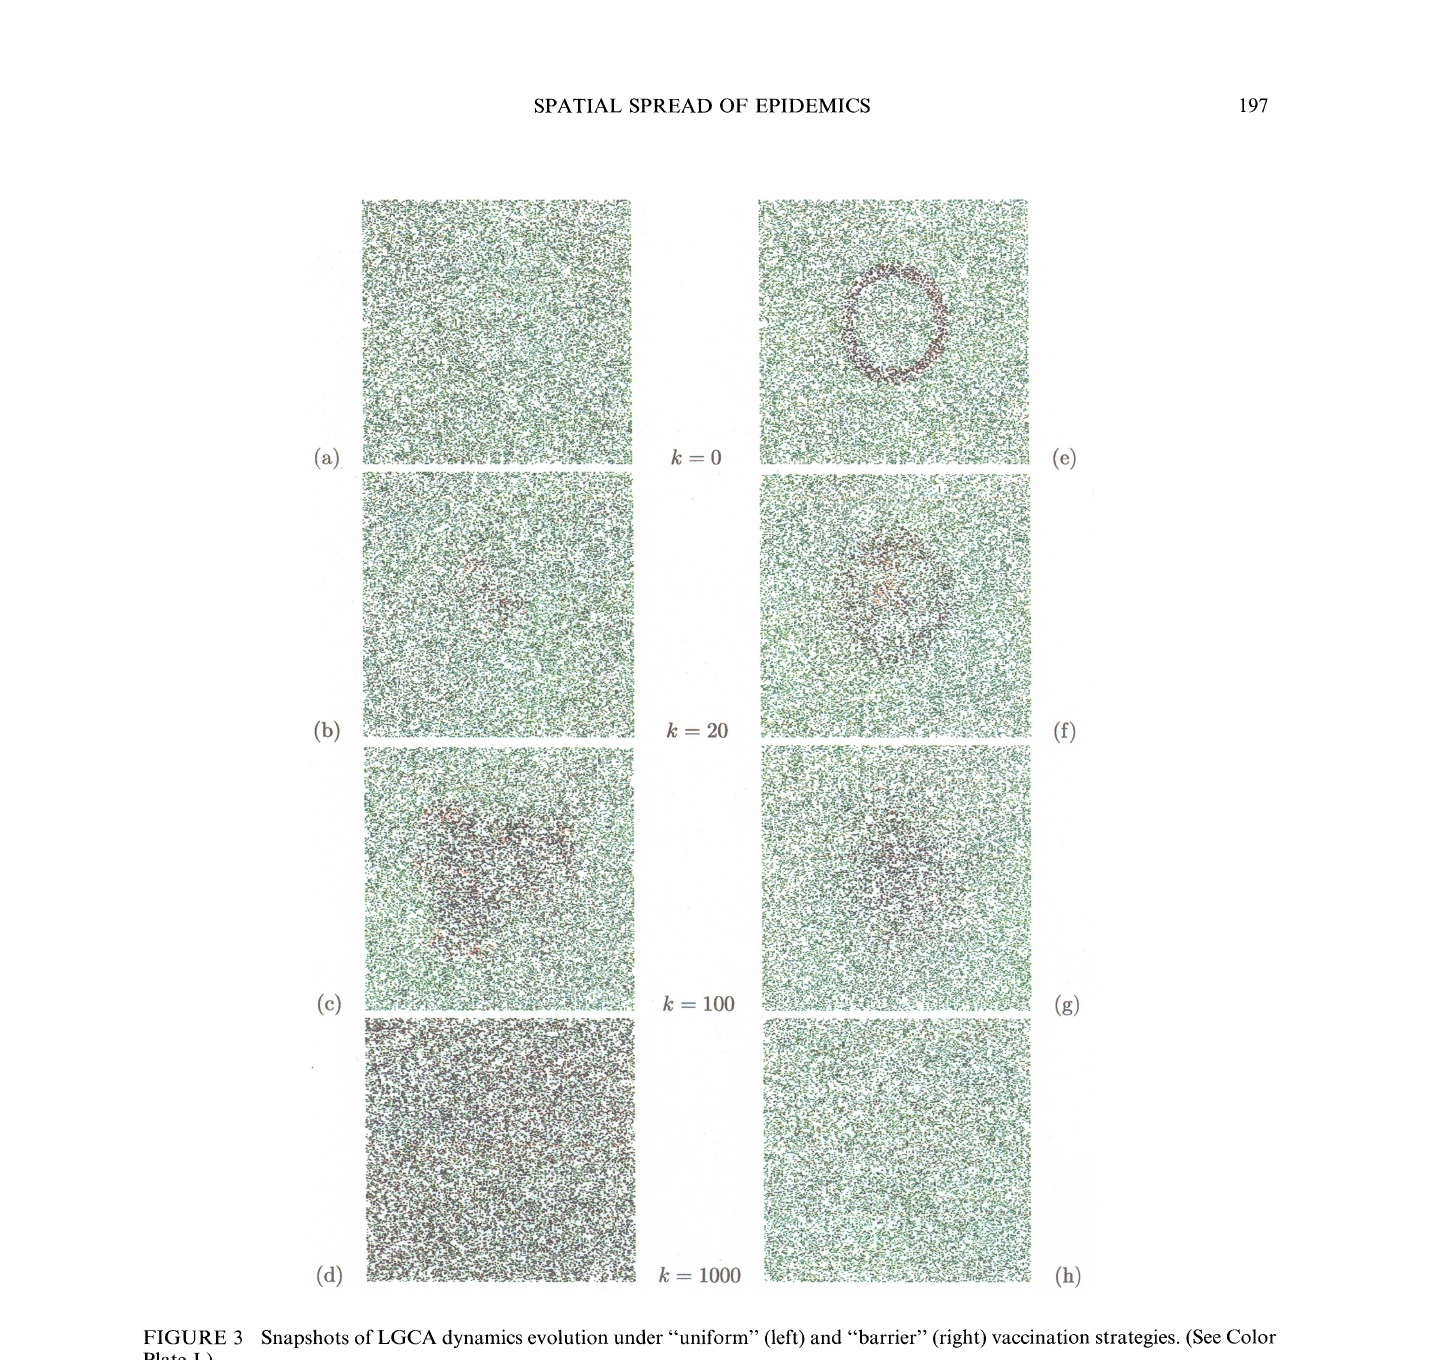
FIGURE 3 Snapshots of LGCA dynamics evolution under "uniform" (left) and "barrier" (right) vaccination strategies. (See Color Plate